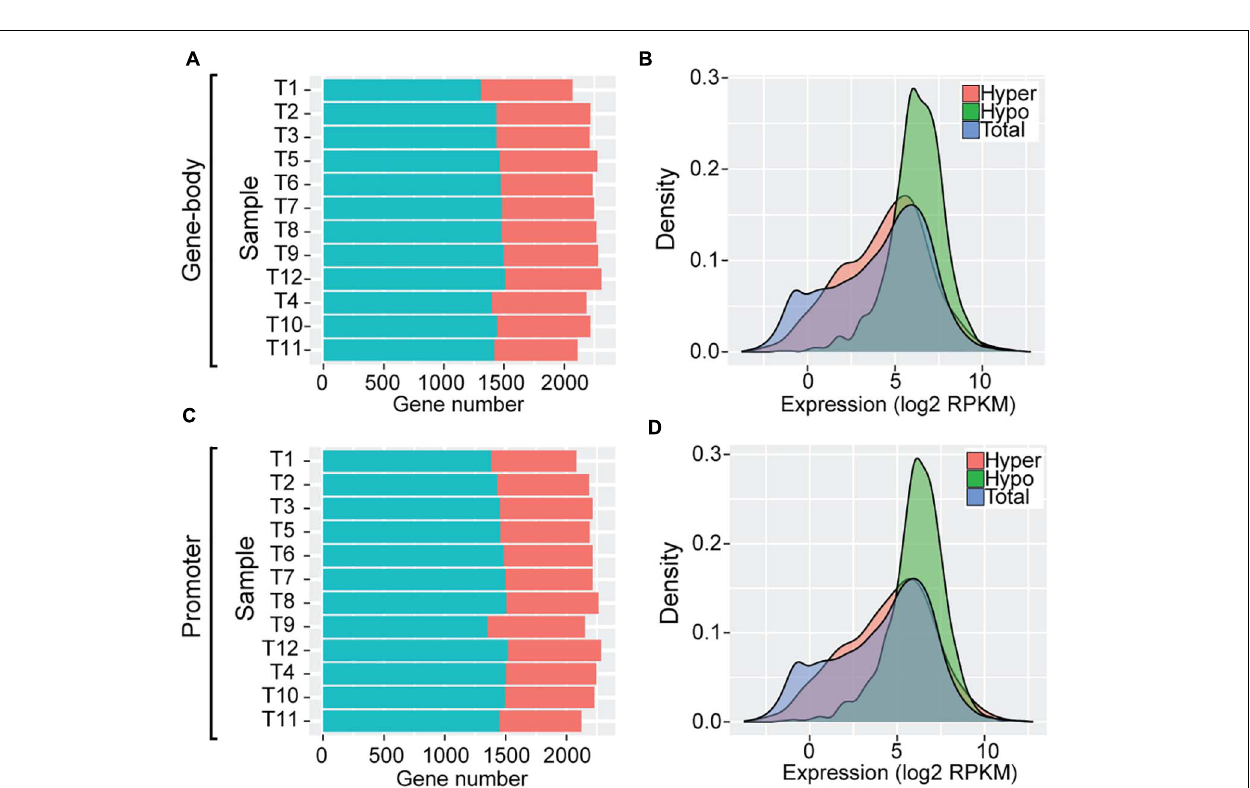
FIGURE 4 | Gene expression patterns of SCOs with hypo/hyper-methylated gene-bodies or promoters of T. pseudospiralis . (A,C) Numbers of hyper-/hypo-methylated SCOs in gene-body (A) and promoter (C) regions. (B,D) Comparison of expression level density of genes exhibiting hyper-/hypo- features in gene-bodies (B) or promoters (D) in Ad stage. “Total” represents the number of total genes across the whole genome and is color-coded in blue. “Hyper” and “Hypo” represent the number of genes with hyper- or hypo- methylated SCOs in gene-bodies or corresponding promoters and are color-coded in red and green,